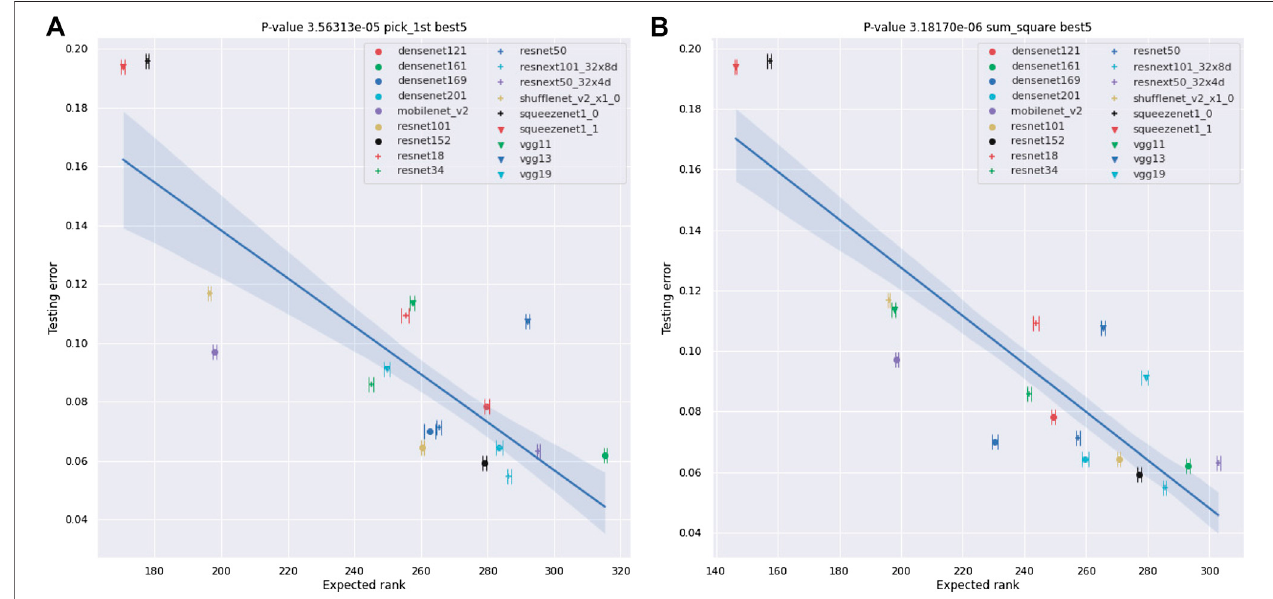
FIGURE 10 | Plots of the best-5 testing error of NNs against their ESD. As in Figure 9 , the testing errors are as provided by [30] and are error rates for testing on ImageNet crop images. We also provide the range of the ESD over 10 different experiments using synthetic data of the form x ∈ {− 1 , 1 } 3 × 224 × 224 , and, again, the ranges are quite small relative to the differences between the various networks. Also in this case, the ESD shows a strong negative correlation with the best-5 error. The con fi dence bounds on the linear fi t are one- σ bounds based on 1,000 bootstrap samples.